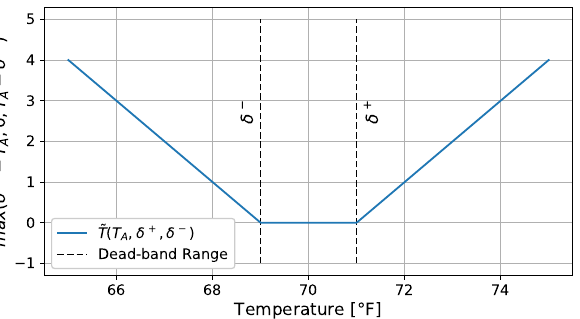
Figure 6. Objective soft constraint ˜ T calculated using double hinge